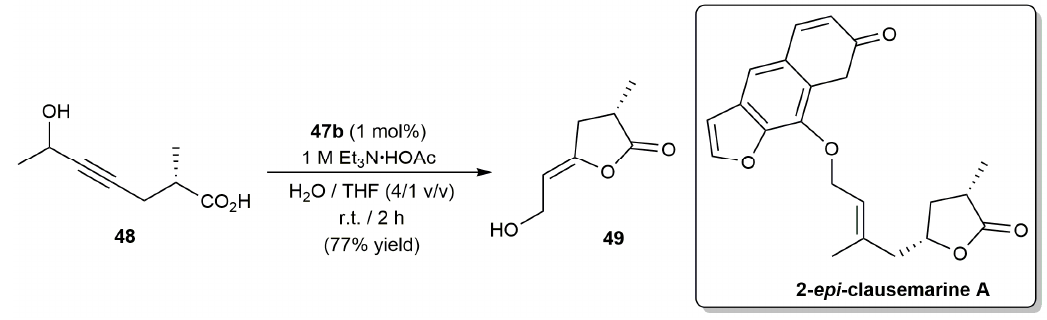
Figure 4. Structures of the gold(I) complex 50 and the PEG-tagged imidazolium salts 51-52